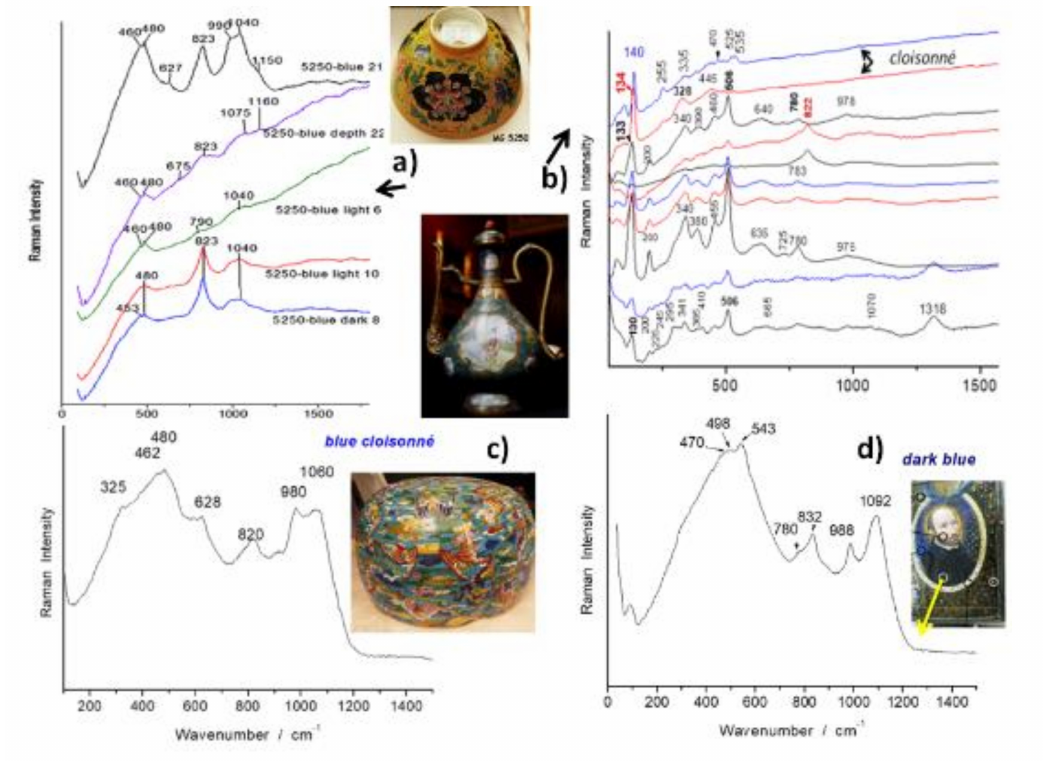
Figure 14. Representative Raman signatures recorded on the blue areas of enamelled porcelain and metal objects (Qing Dynasty Chinese artefacts): ( a ) a painted huafalang Imperial porcelain bowl (Kangxi reign mark) [140,222]; ( b ) a painted and cloisonn é metal ewer (Qianlong reign mark); ( c ) cloisonn é metal box (Qianlong reign,19th-Century) (Collections of Mus é e